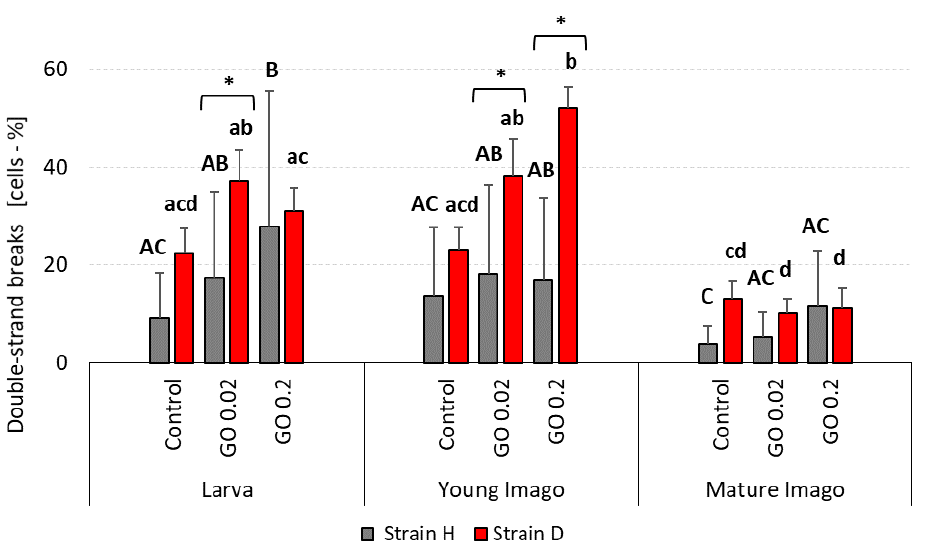
Figure 2. DSB (double strand breaks) in DNA in the gut cells of the wild (H) and long-living (D) strains of A. domesticus that had been chronically intoxicated with graphene oxide (GO). Measurements were conducted at larva (n = 5), young imago (n = 5) and mature imago stage (n = 3). Abbreviations: see Figure 1. Capital letters refer to strain H, while lowercase letters refer to strain D; asterisks indicate differences between the strains in each experimental group separately.